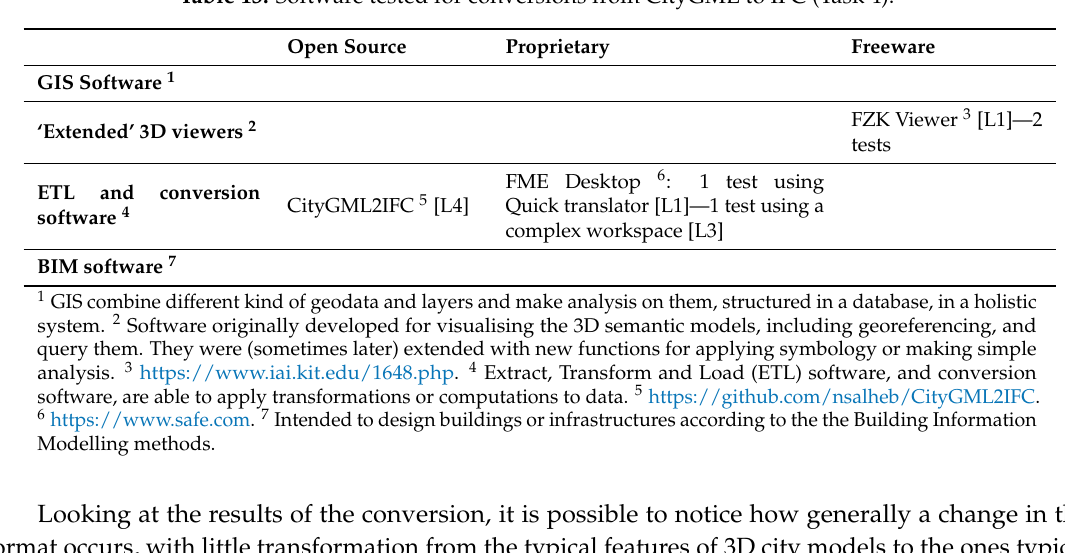
Table 13. Software tested for conversions from CityGML to IFC (Task 4).